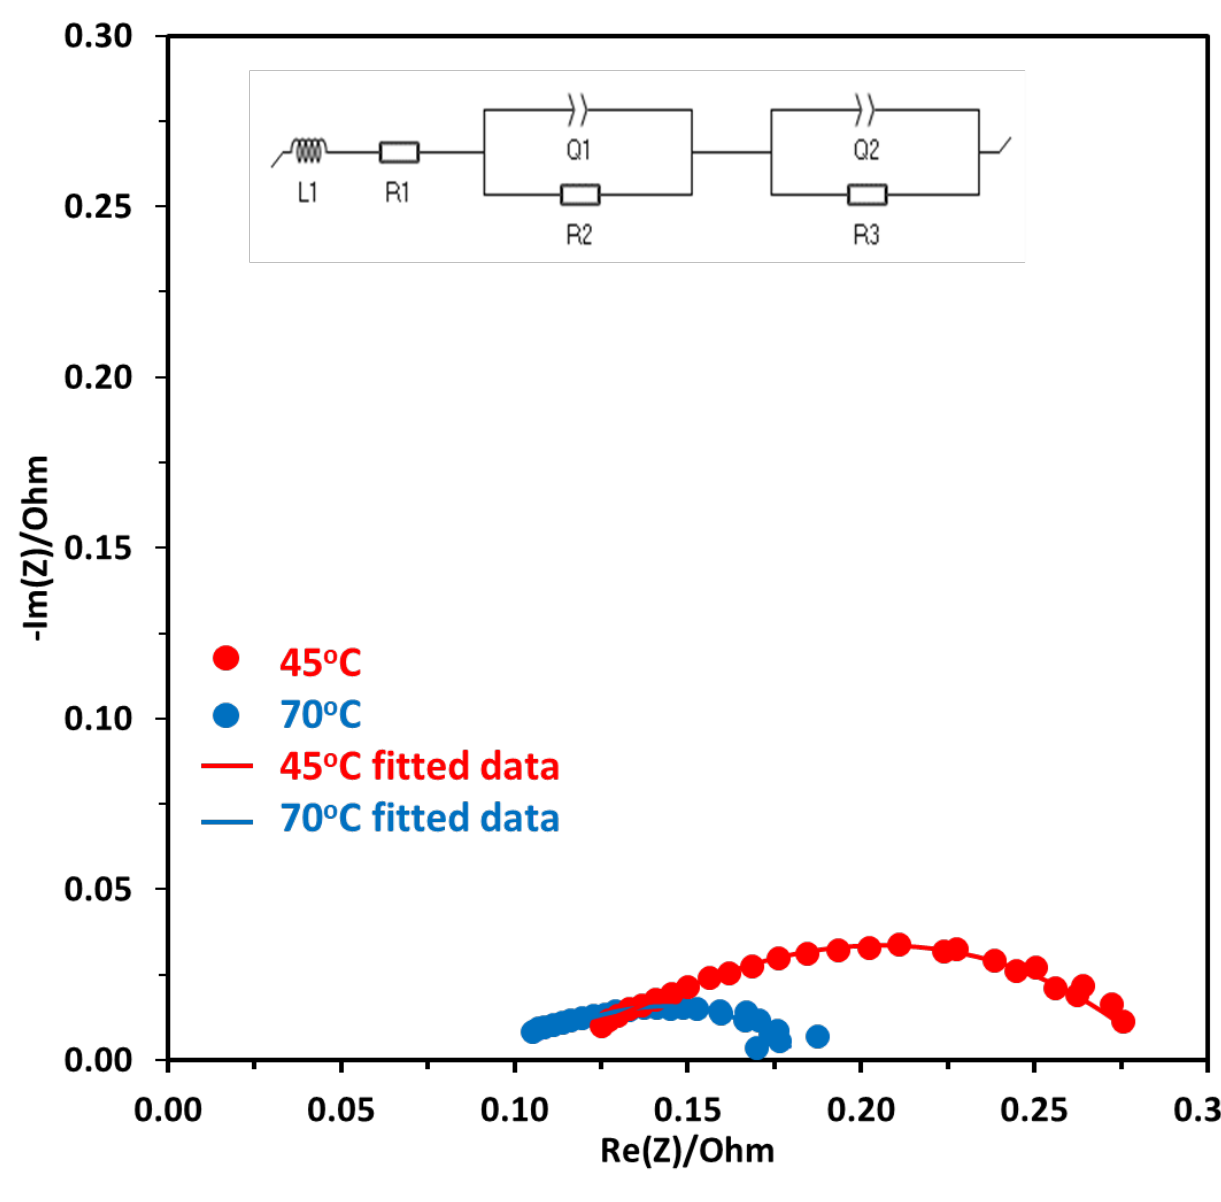
Figure 9. Nyquist plot at a constant voltage of 1.7 V at two different temperatures of 45 ◦ C and 70 ◦ C, Pt/C was used at the cathode and NiFeCoO x was used at the anode. Table 1. Resistances evaluated from equivalent circuit